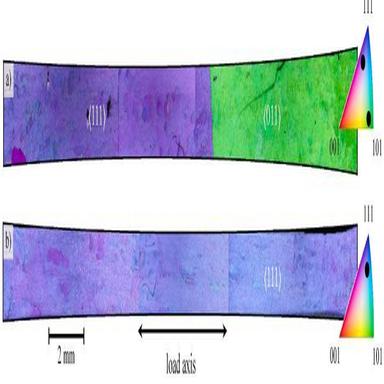
Crystallographic orientation of the tensile specimens in the colors of the inverse pole figure plotted according to the load axis (horizontal). (a) Bi-crystal with orientations close to 〈111〉 and 〈011〉, respectively. (b) Single crystal with orientation close to 〈111〉. (For interpretation of the references to color in this figure legend, the reader is referred to the Web version of this article.)